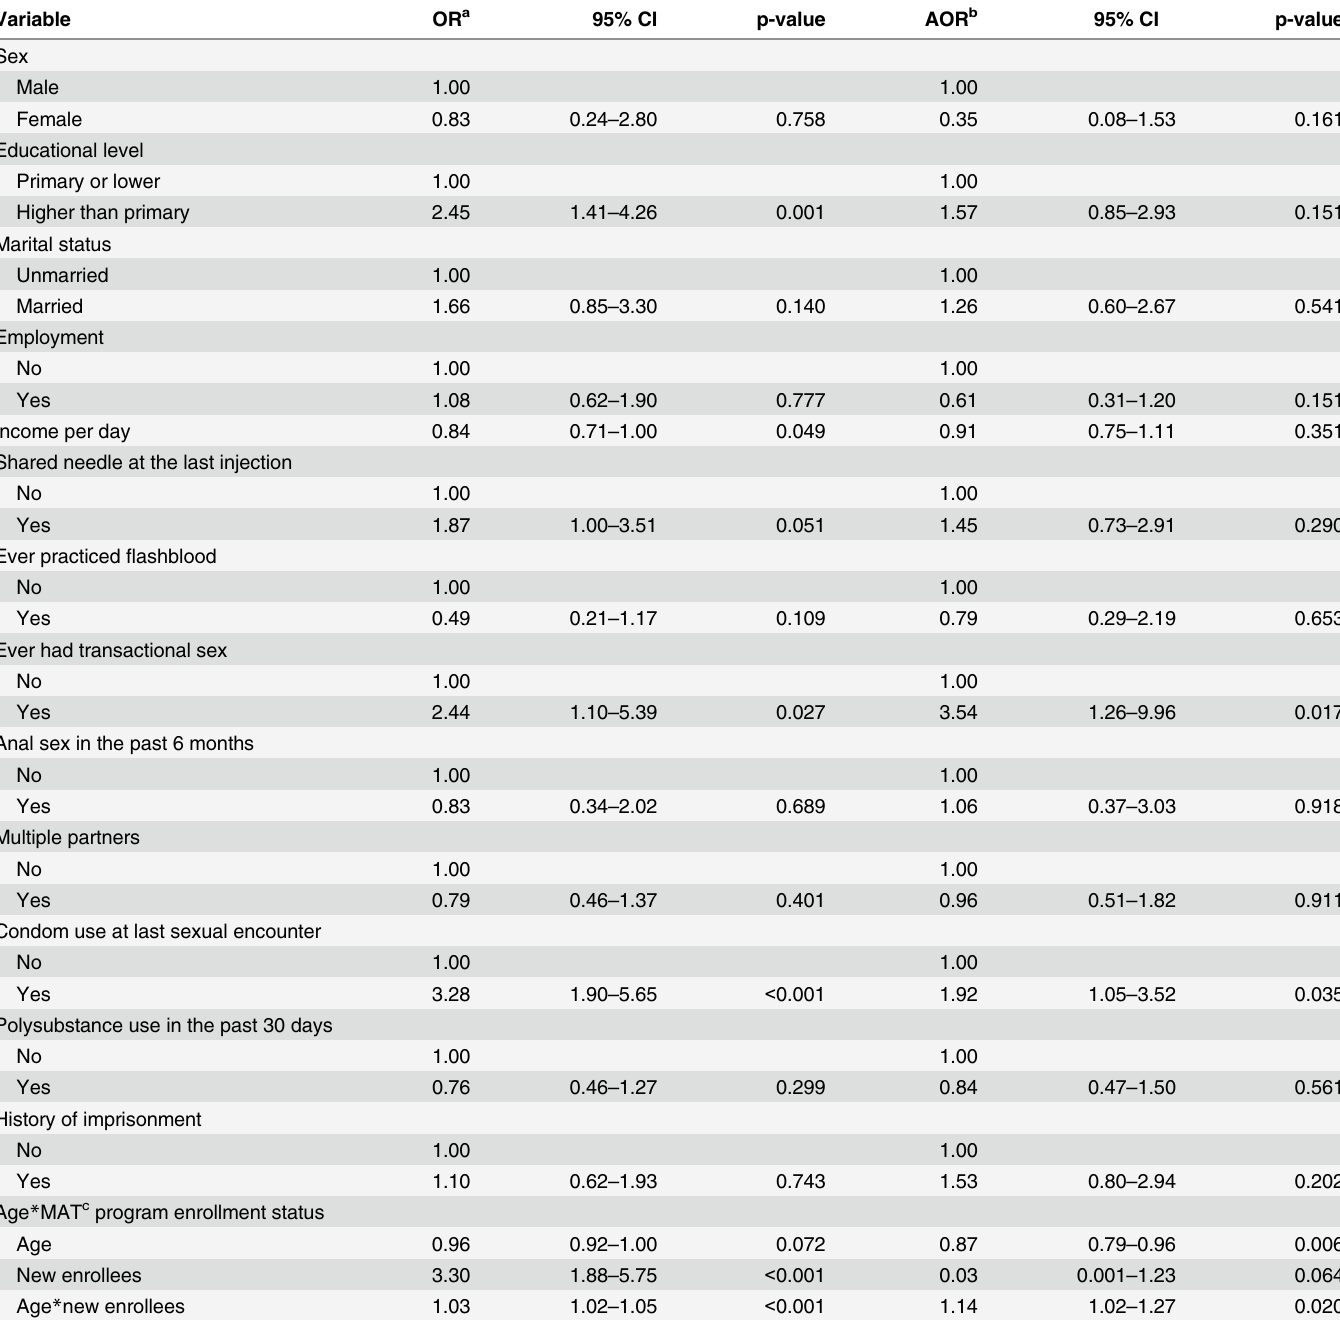
Table 5. Factors associated with ever being screened for sexually transmitted infections among